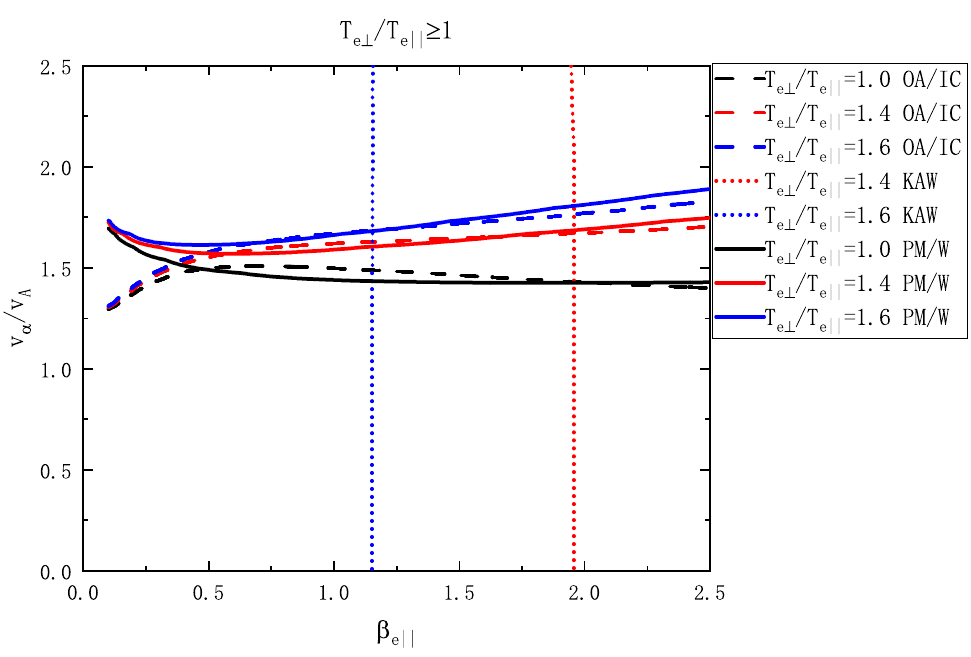
Figure 12. The same as Figure 6, but for T e ⊥ / T e (cid:107) ≥ 1, where the solid, dotted, and dashed lines represent the PM/W, KAW, and OA/IC instabilities, respectively, and the black, red, and blue lines represent T e ⊥ / T e (cid:107) = 1, 1.4, and 1.6,